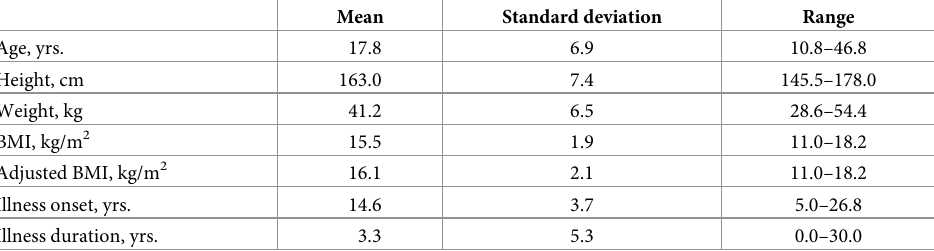
Table 1. Demographic data of